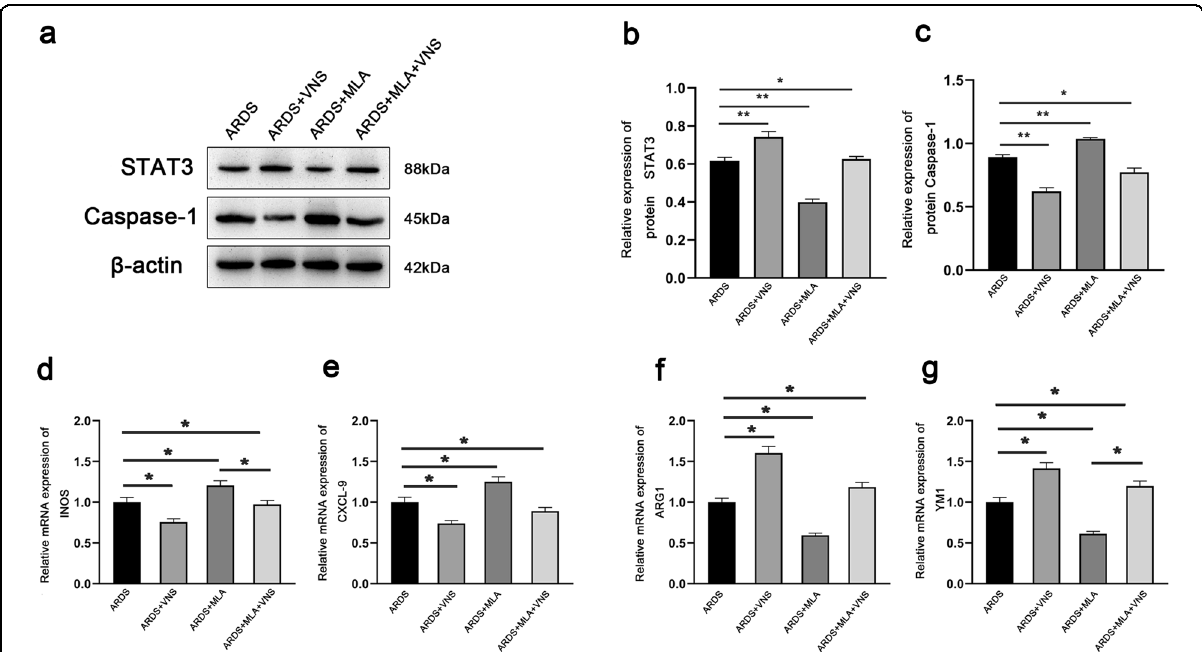
Fig. 4 The α 7nAchR inhibitor methyllycaconitine citrate (MLA) weakens the effects of VNS on STAT3, Caspase-1, and M1M2 macrophage phenotypes. a Representative western blotting images of STAT3 and Caspase-1 expression in the ARDS group, ARDS + VNS group, ARDS + MLA group, and ARDS + MLA + VNS group ( n = 6 biological replicates). b , c Comparison of mean intensity ratios for STAT3 and Caspase-1 between the ARDS group, ARDS + VNS group, ARDS + MLA group, and ARDS + MLA + VNS group ( n = 6 biological replicates). d – g The mRNA levels of the M1 macrophage markers, iNOS and CXCL-9, and the mRNA levels of M2 macrophage markers, Arg1 and Ym1, were measured in the ARDS group, ARDS + VNS group, ARDS + MLA group, and ARDS + MLA + VNS group by qPCR and normalized to GAPDH mRNA levels ( n = 6 biological replicates). The results are expressed as the mean ± SEM ( n = 6 biological replicates); * p < 0.05, ** p <